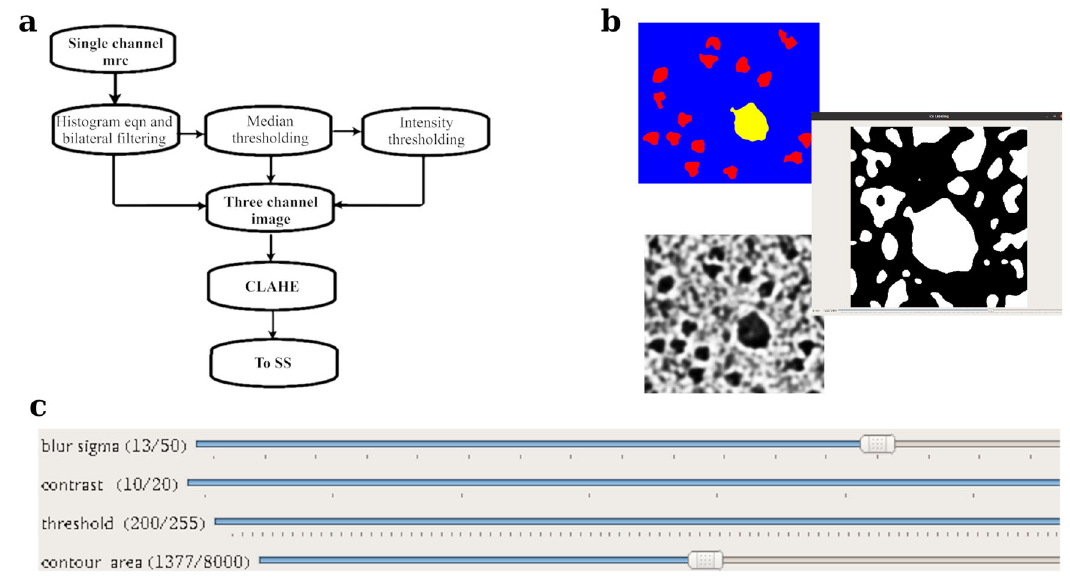
Fig. 9 Flowchart representing pre-processing and labeling tool in CASSPER training phase. a The fl owchart showing the pre-processing steps of CASSPER training phase. The single channel micrograph is enhanced and three different fi lters are applied to get the inputs for three channel images. b Figure showing the ice labeling method. c The toolbar section of the GUI which was used for labeling the